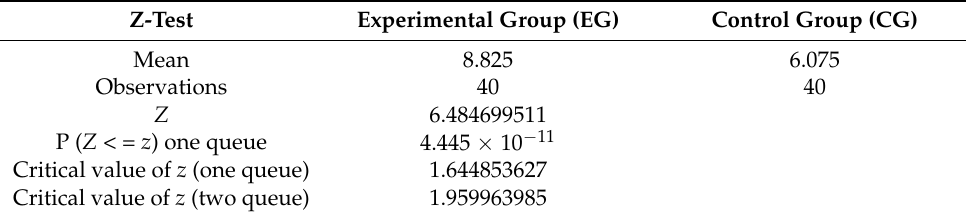
Table 4. Z-test scores for two groups: experimental group (EG) and control group (CG).